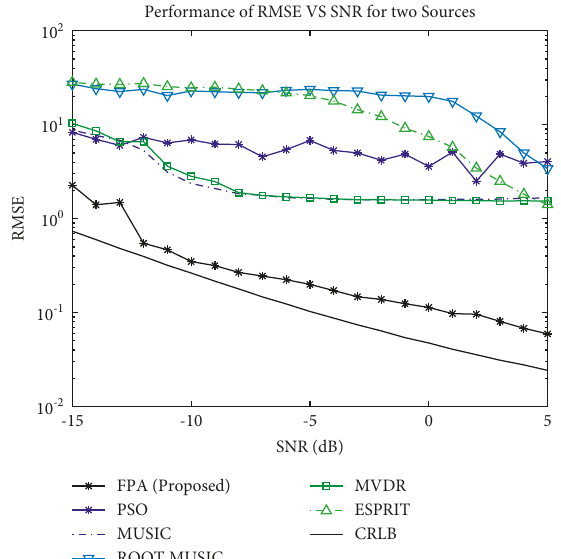
Figure 9: Robustness against the number of elements for two sources of 5dB of